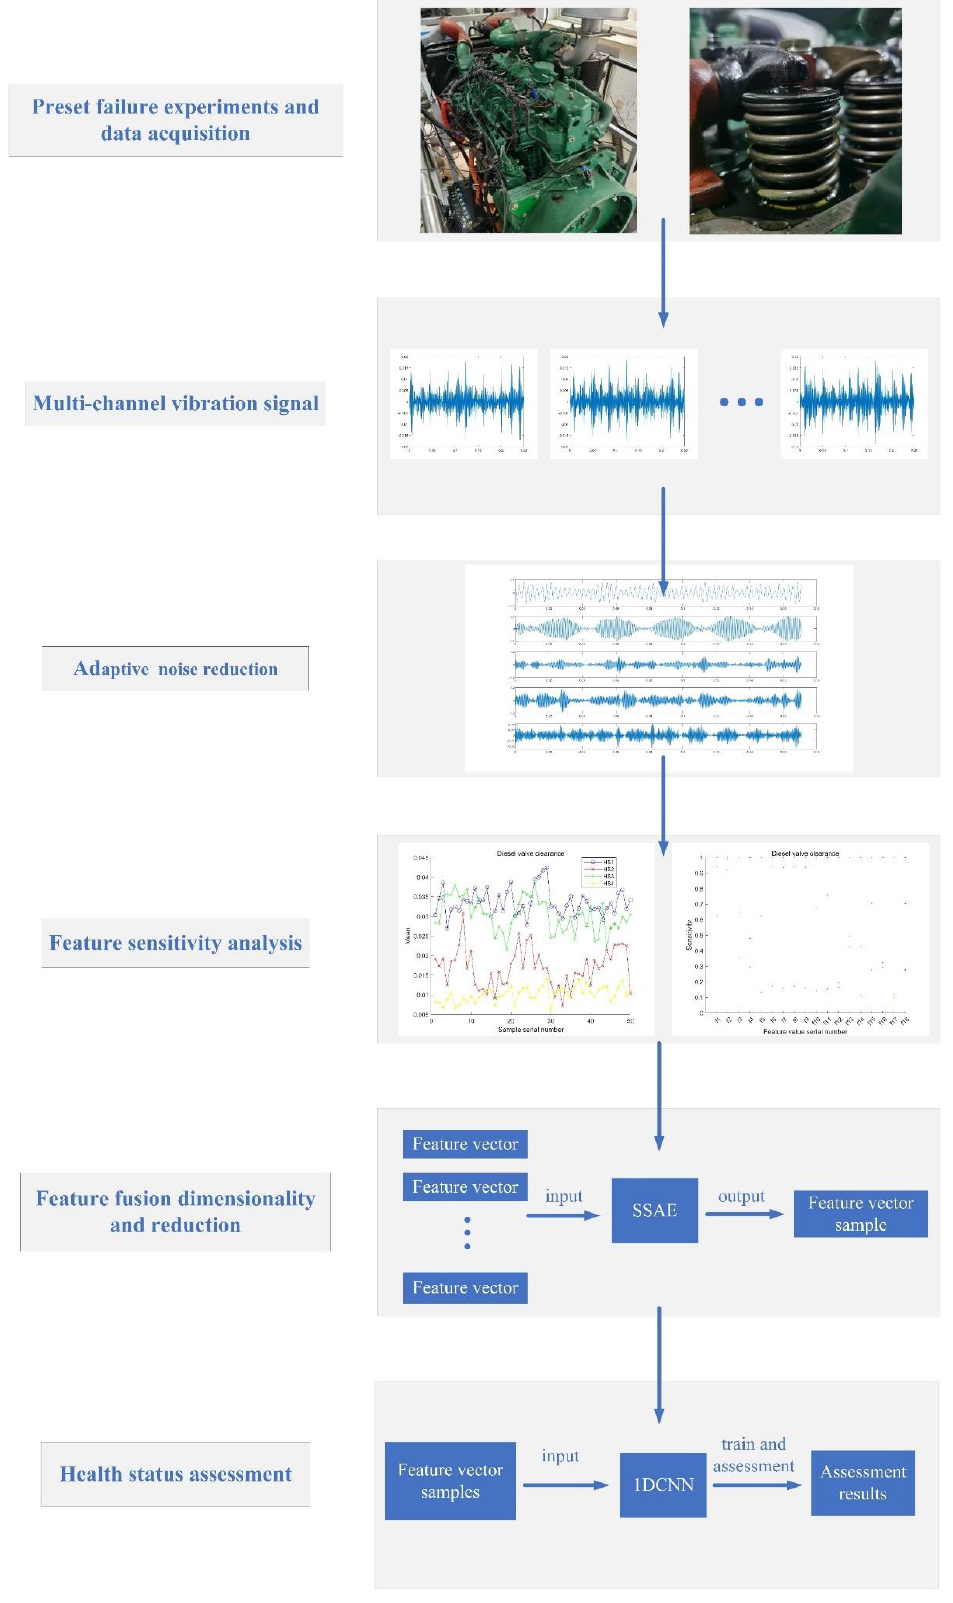
Figure 6. The flowchart of the proposed diesel engine valve clearance state assessment method.